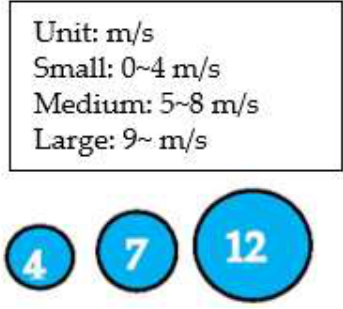
Figure 4. The levels of wind speed.